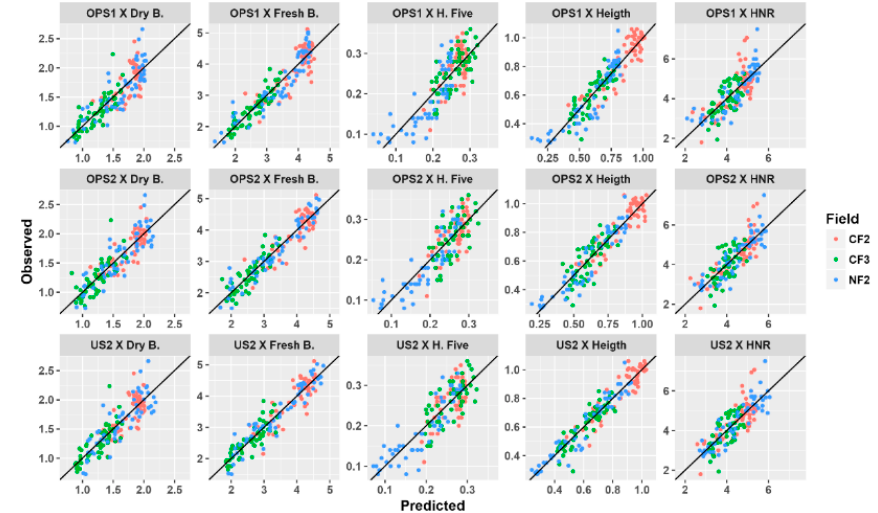
Figure 5. Sensor performance to predict crop parameters: dry biomass (Dry B.), fresh biomass (Fresh B.), height of top five nodes (H. Five), crop height (Height) and height-to-node ratio (HNR) with three crop sensors: OPS1: N-Sensor™ ALS; OPS2: Crop Circle ACS 430; US2: HC-SR04; for cotton cultivated